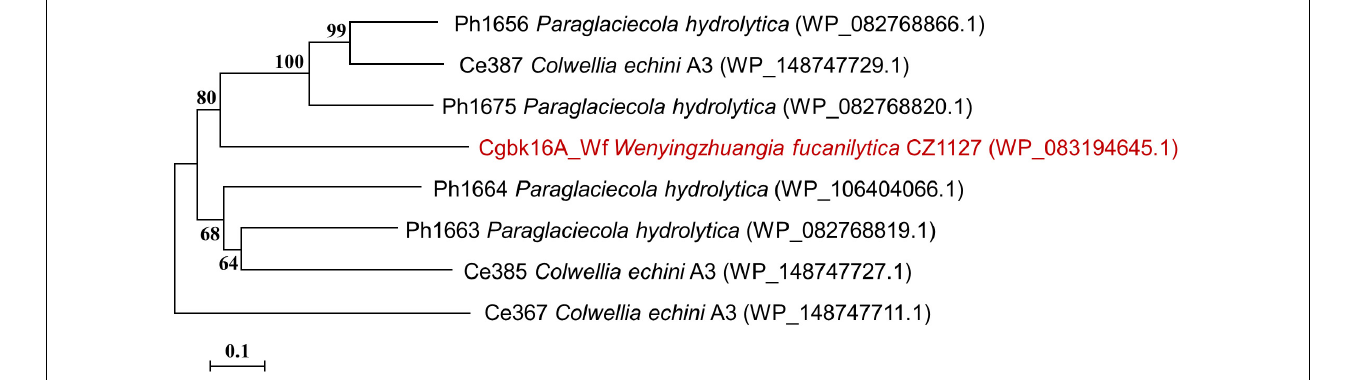
Frontiers in Microbiology |